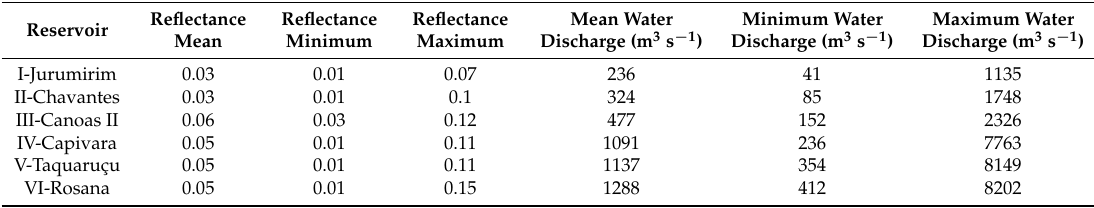
Table 2. Descriptive statistics for the reflectance and water discharge time series recorded between February 2000 and December 2012 for the six studied dams: I-Jurumirim, II-Chavantes, III-Canoas II, IV-Capivara, V-Taquaruçu and VI-Rosana.